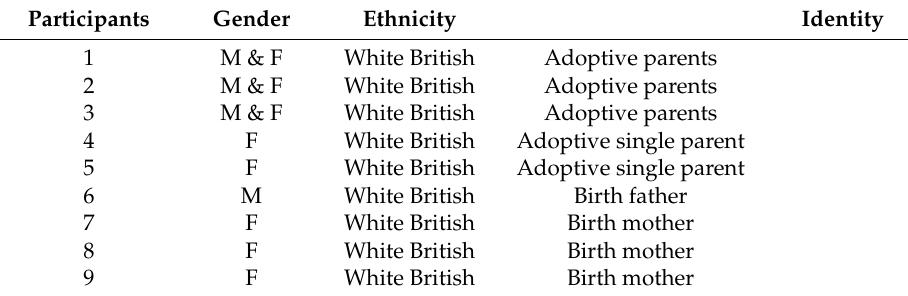
Table 1. Research